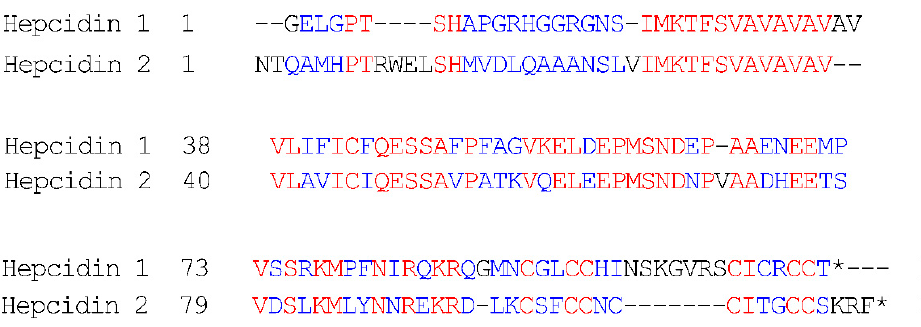
Figure 1. Translated amino acid sequence of target hepcidin genes and BLAST (Basic Local Alignment Search Tool) alignment results. Those identical deduced amino acid residues were marked in red, indicating conversed amino acid sequence, and those di ff erent deduced amino acid residues were marked in